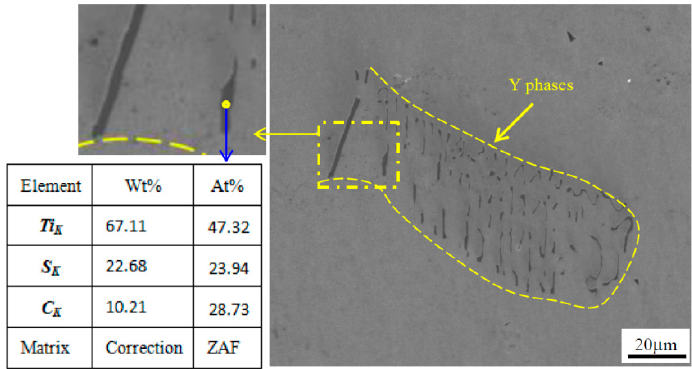
Figure 3. SEM image and EDS analysis of Y phases in AISI 321 form the cast ingot.